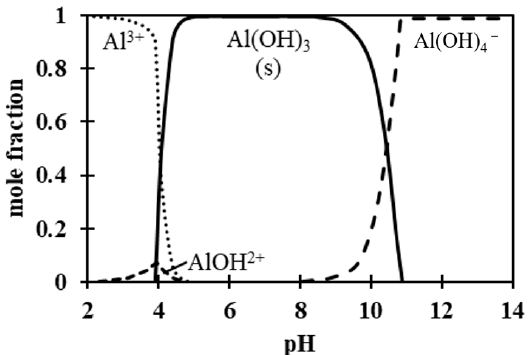
Figure A1. Dependences of Al(III) forms on the pH value of the aqueous solutions (c 0 = 0.15 mmol dm − 3 ).